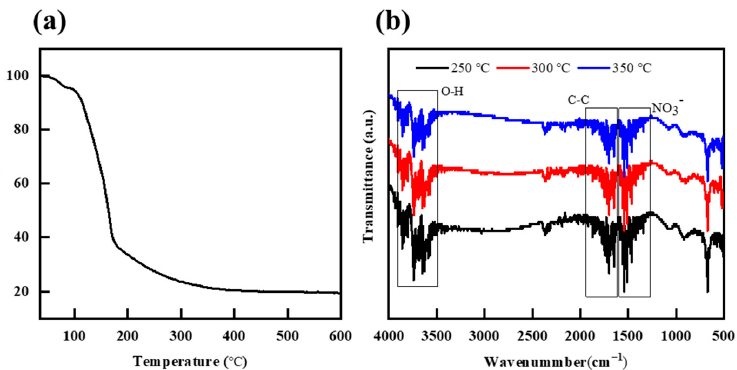
Figure 1. ( a ) TG curve of the AlO x precursor from 35 to 600 ◦ C. ( b ) FT-IR spectra of the AlO x films annealed at different temperatures.